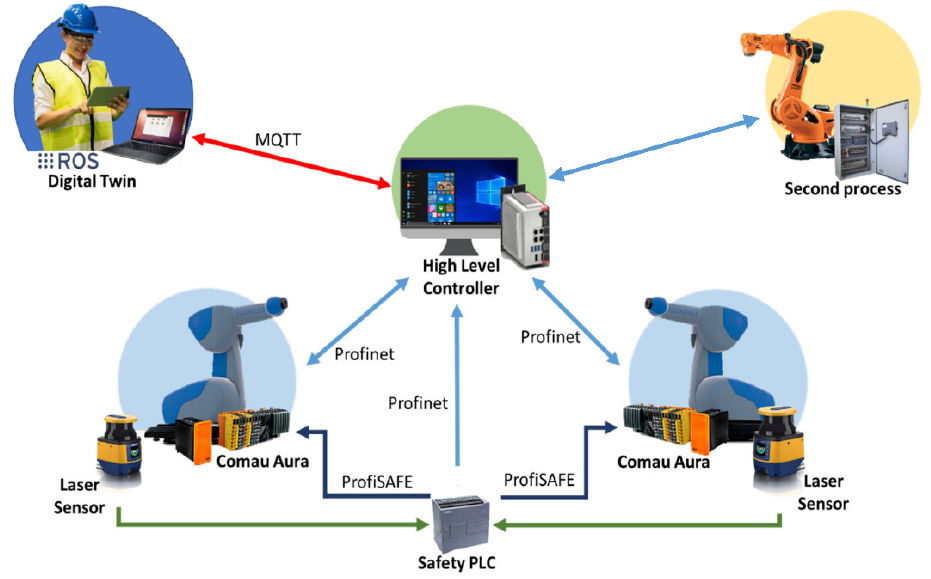
Figure 2. Architecture of the